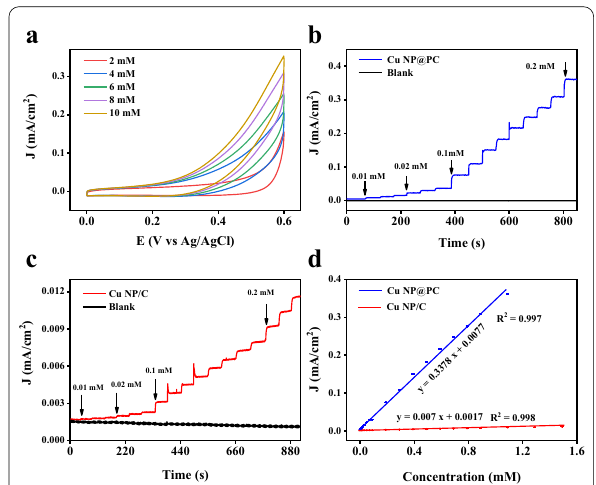
Fig. 5 a CV curves of Cu NP@PC in 0.1 M KOH with the presence of glucose at different concentrations of 2, 4, 6, 8 and 10 mM. Scan rate: 100 mV/s; b The amperometric responses of Cu NP@PC upon successive addition of glucose solution in 0.1 M KOH at 0.55 V (vs Ag/ AgCl); c The amperometric responses of Cu NP/C upon successive addition of glucose solution in 0.1 M KOH at 0.55 V (vs Ag/AgCl); and d The corresponding calibration curves of the Cu NP@PC and Cu NP/C for glucose sensing. The error bars were obtained based on three repeats of the experiment